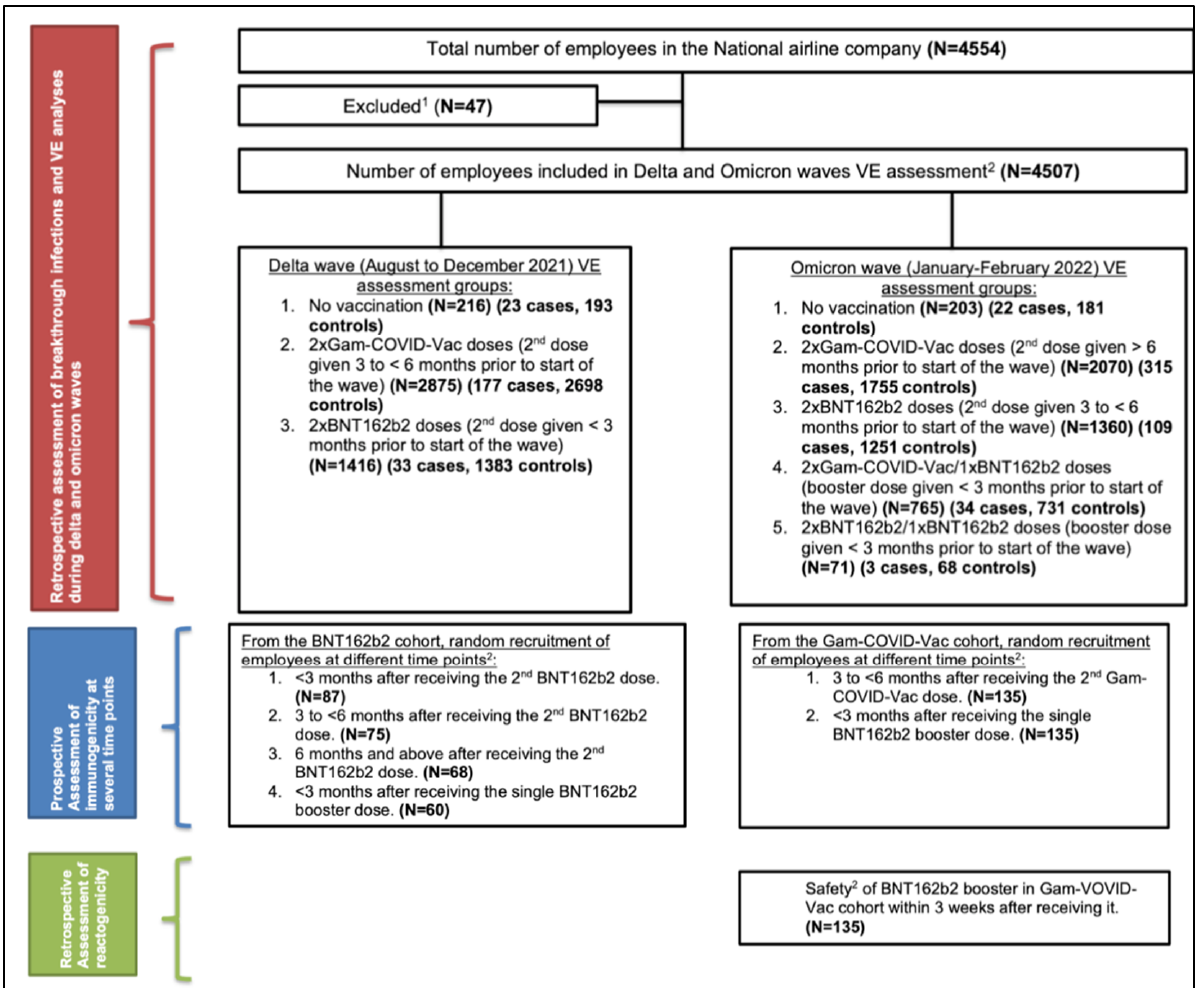
Figure 1. Study profile. VE: vaccine effectiveness. N.B.: 1 Employees who were on renal replacement therapy or had any history of congenital or acquired immunosuppression (including asplenia, congenital or acquired immunodeficiency, solid/hematologic malignancy or disease on chemotherapy or immunosuppressive therapy, solid organ transplant, or long-term systemic corticosteroids and radiation therapy) were excluded. Employees who received vaccines other than BNT162b2 or Gam-COVID-Vac were excluded from the analysis. 2 Employees from all age groups and from both genders were included in vaccine effectiveness, immunogenicity and safety analyses.